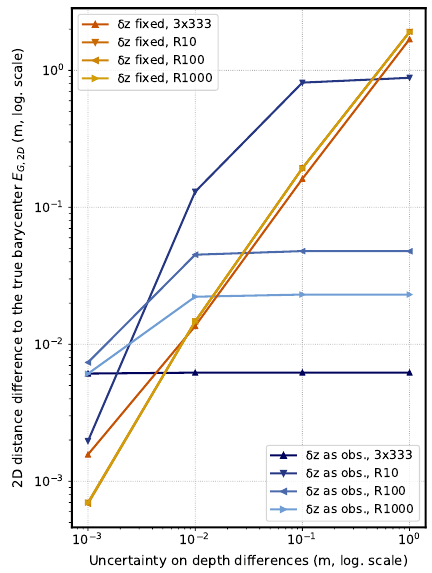
Figure 5. Distance to true barycenter for different uncertainties in depth differences, using an inversion mode with δ z as observables in the least-squares sense (cold colors) and with δ z as fixed values (warm